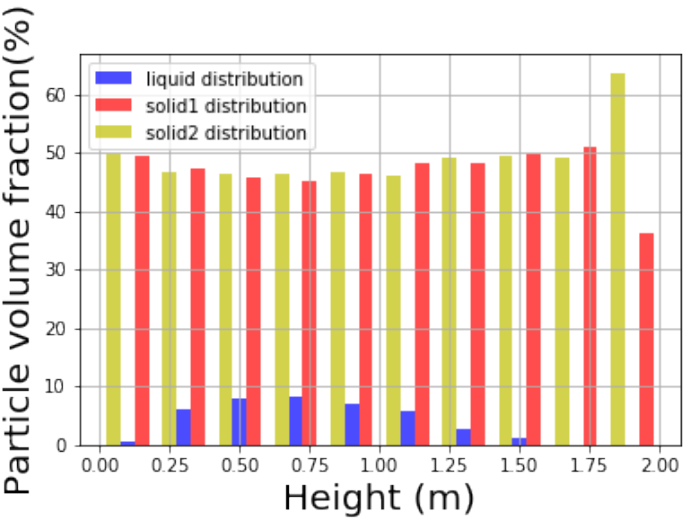
Figure 11. Particle volume fraction on height.